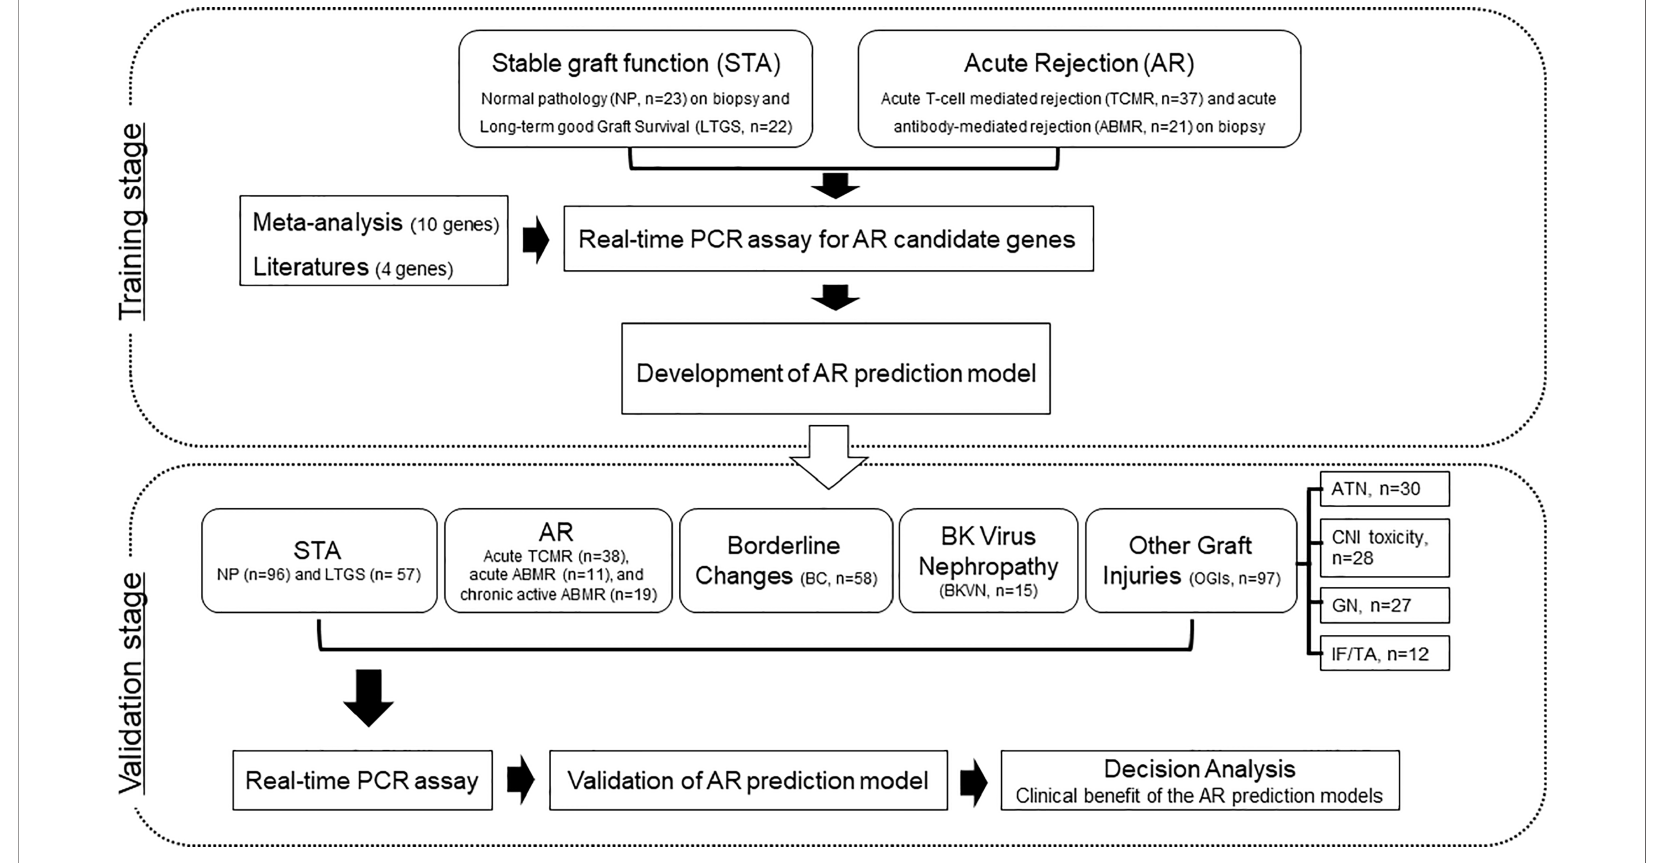
FIGURE 1 | Work fl ow of biomarker discovery and validation for the diagnosis of AR in urine pellets. After a meta-analysis and review of the published literature to obtain candidate genes for diagnosis of AR, we measured the levels of 103 training samples composed of stable (STA, n=45), and acute rejection (AR, n=58) using absolute qPCR methods. We developed a signature by combining signi fi cantly different transcripts to distinguish AR from STA. We validated signi fi cant mRNAs and tested the performance of the diagnostic signature in 391 independent samples including STA (n=153) composed of NP (n=96) and long-term graft survival (LTGS, n=57), AR (n=68) composed of acute TCMR (n=38), acute ABMR (n=11), and chronic active ABMR (n=19), borderline changes (BC, n=58), BKVN (n=15), and other graft injuries (OGIs, n=97) including acute tubular necrosis (ATN, n=30), calcineurin inhibitor (CNI, n=28) toxicity, glomerulonephritis (GN, n=27), and interstitial fi brosis/tubular atrophy (IF/TA, n=12). We also performed a decision curve analysis to determine the value of the signature in predicting